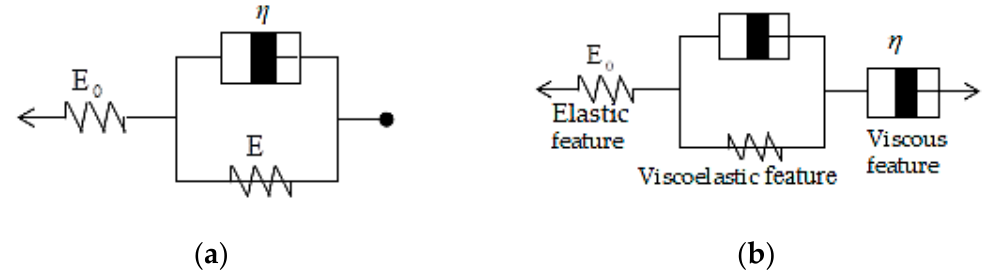
Figure 1. Flexible polymer mold viscoelastic response ( a ) Maxwell model ( b ) creep prediction model.